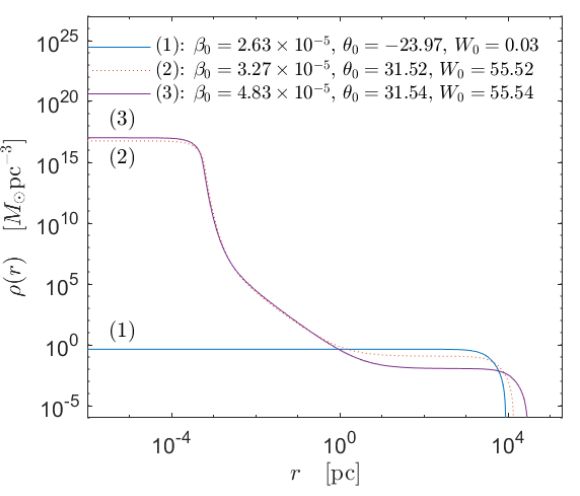
Figure 14. Density profiles for mc 2 = 48 keV corresponding to the equilibrium states of the caloric curve in Figure 13 with corresponding fixed total halo mass. Only profile (1) (resembling a King distribution) and the core − halo one (3) are stable, while profile (2) is thermodynamically unstable. Interestingly, solutions such as (3) were successfully applied to explain the DM halo in the MW in [32]. They are stable, extremely long − lived, and fulfill the observed surface DM density relation and the expected value of the DM dispersion velocity. Reproduced from [11] with the authors’